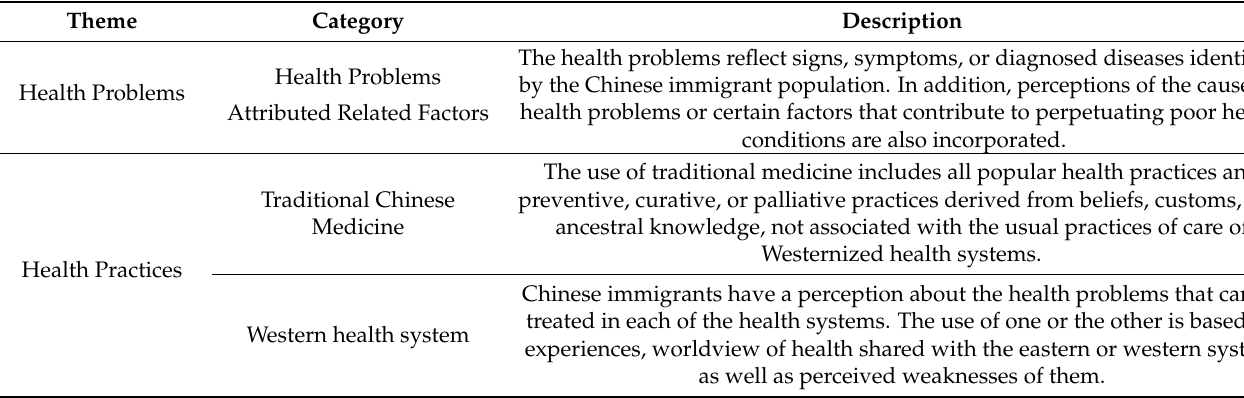
Table 2. Emergent themes and